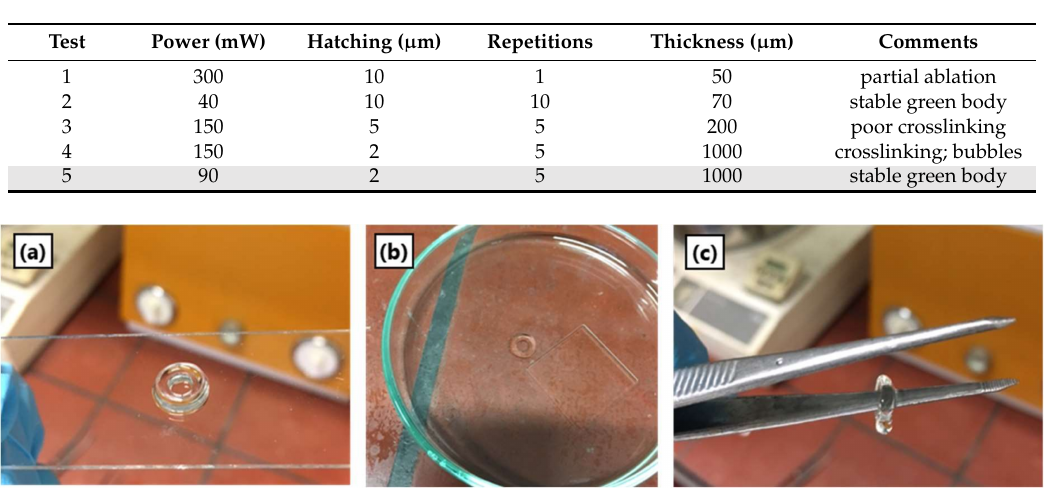
Figure 6. Ceraset green body formed by single layer laser crosslinking (266 nm system with power of 90 mW and hatch width of 2 µ m). ( a ) Green body after solvent wash; ( b ) demonstrated removal from substrate; ( c ) demonstrated mechanical